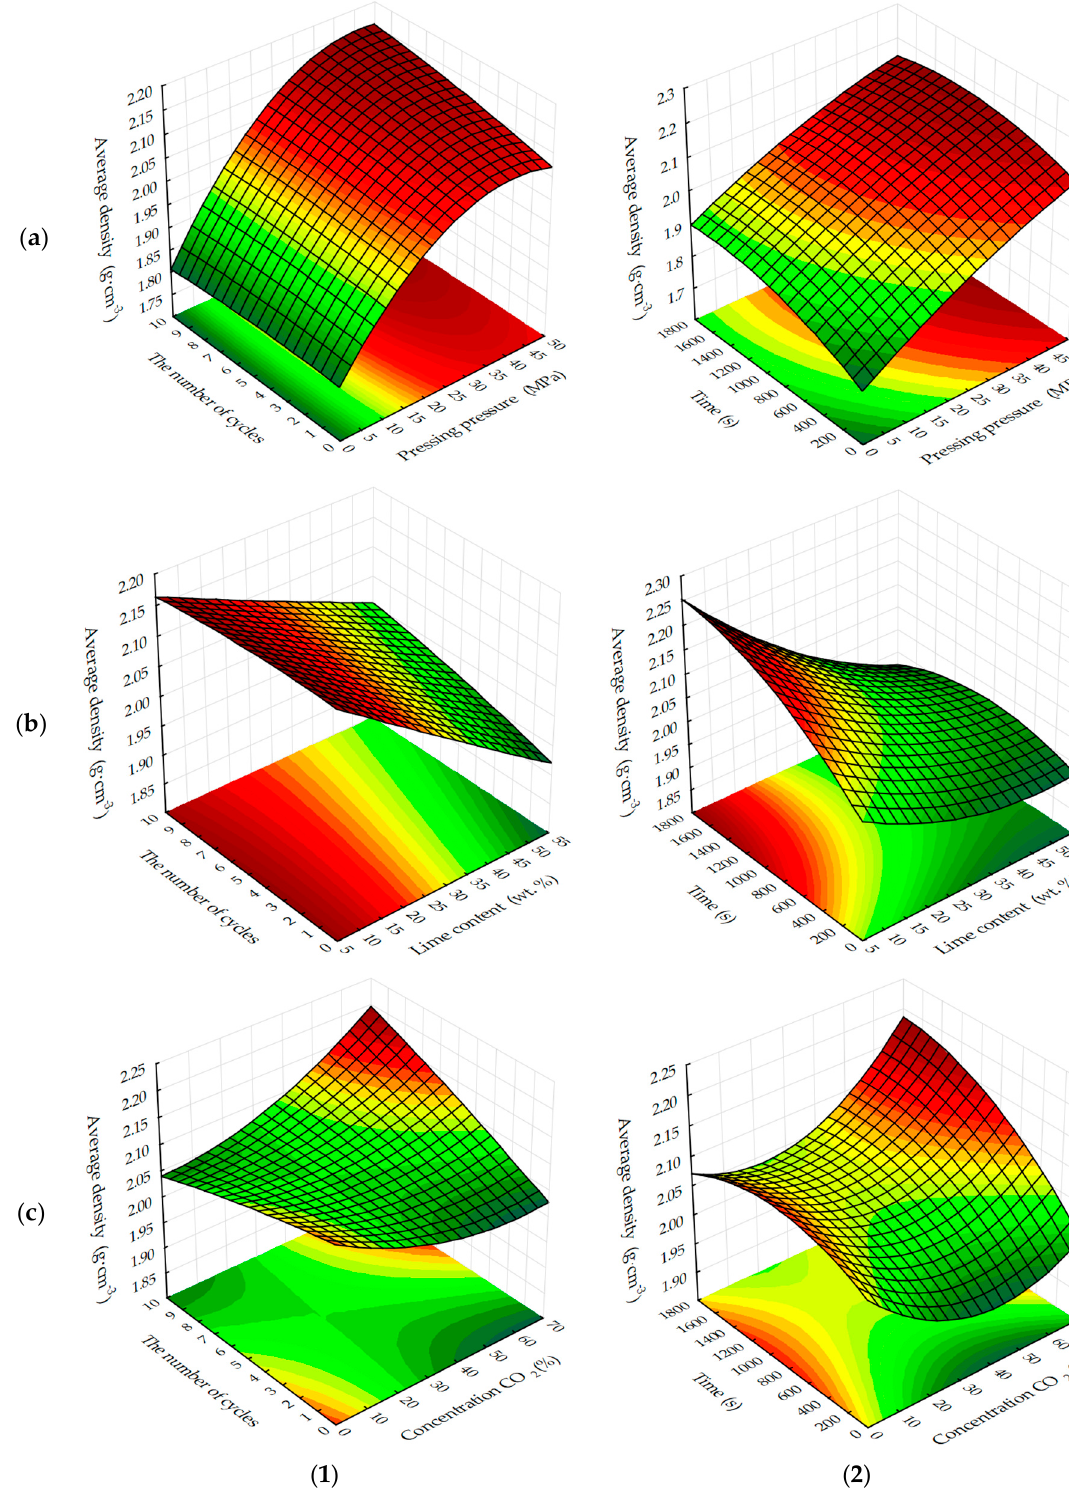
Figure 6. Response surfaces to changes in the average density of testing samples carbonated by dynamic ( 1 ) and static ( 2 ) methods depending on the number of cycles/carbonation time and: ( a ) pressing pressure; ( b ) lime dust content; ( c ) CO 2 concentration (at zero level of variation of other factors).